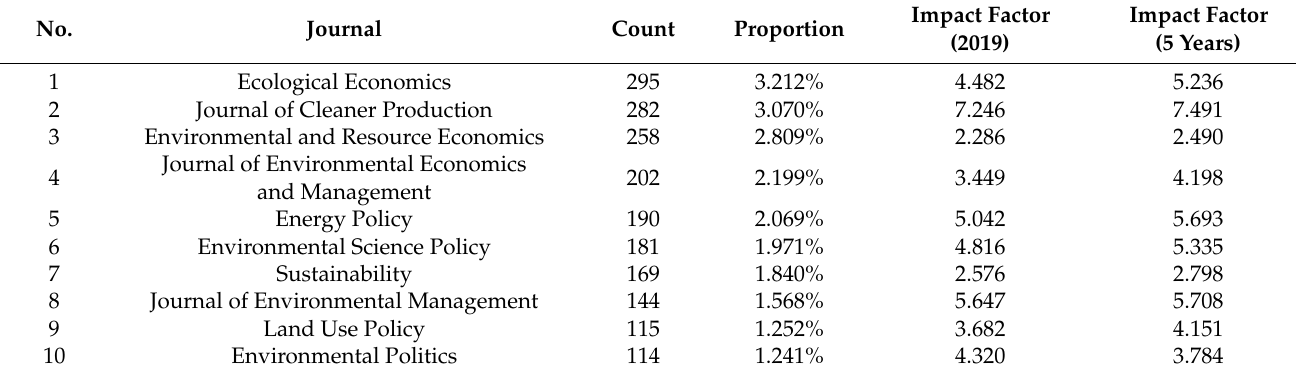
Table 2. Journals with the highest contribution in research on environmental regulation from 2000 to